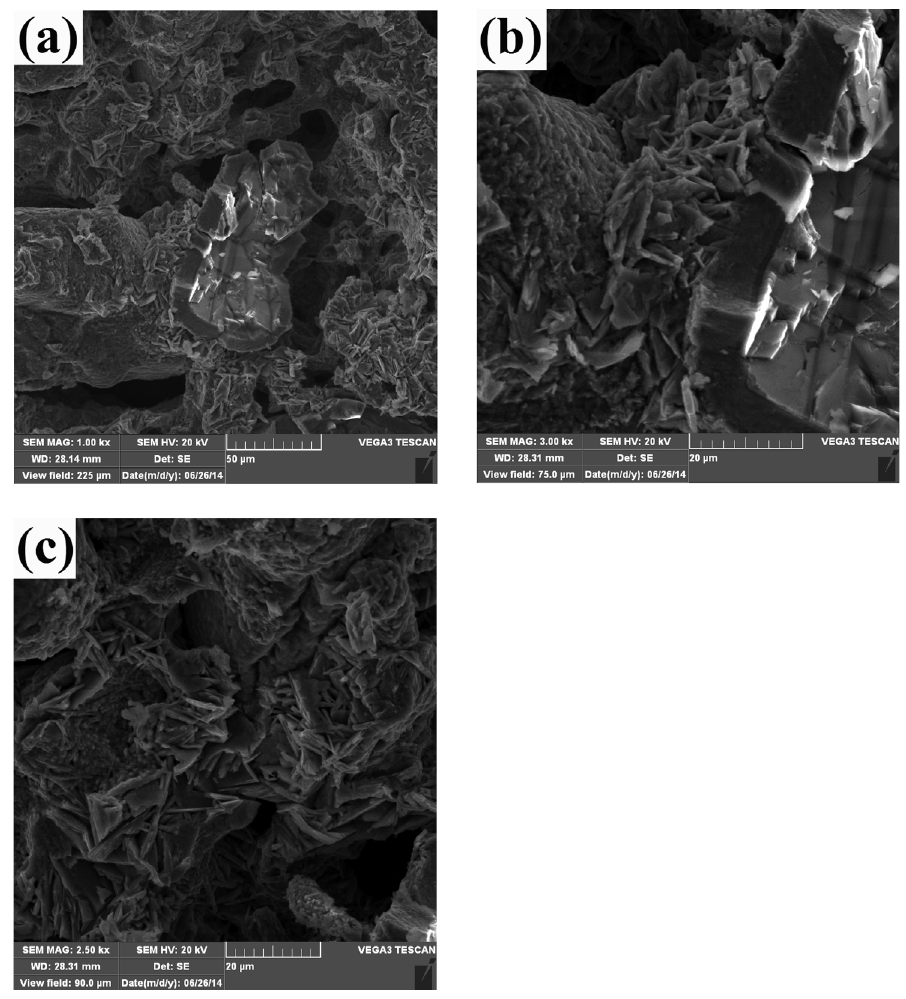
Figure 3: Fracture micrograph of the synthesized sample containing 20% c-BN (120/140 mesh). (a) low latitude morphology, (b) the interface morphology between c-BN and the matrix, (c) the morphology of